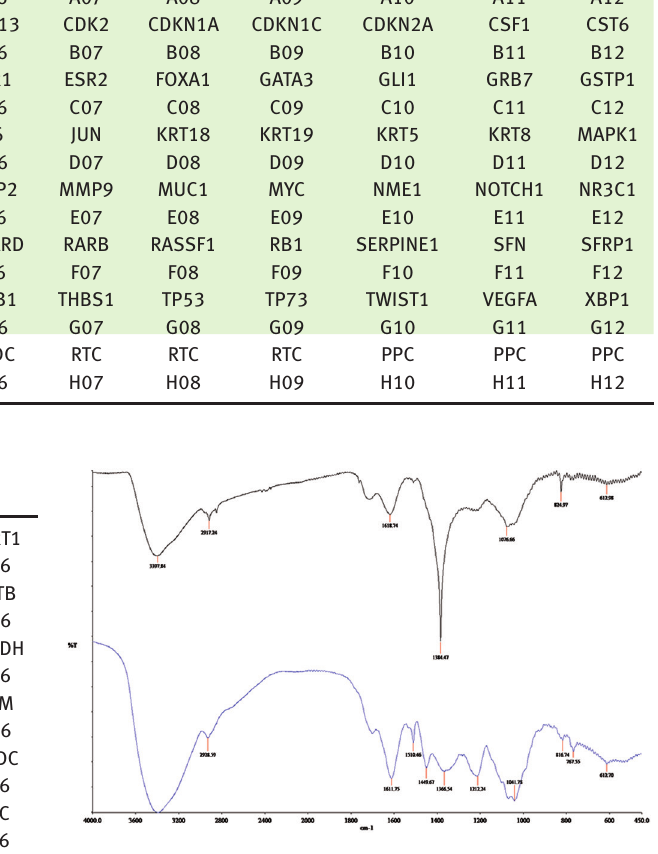
Figure 2: FT-IR spectra of A. aestivus aqueous extract ( ASP ) and FeNP synthesized from ASP A